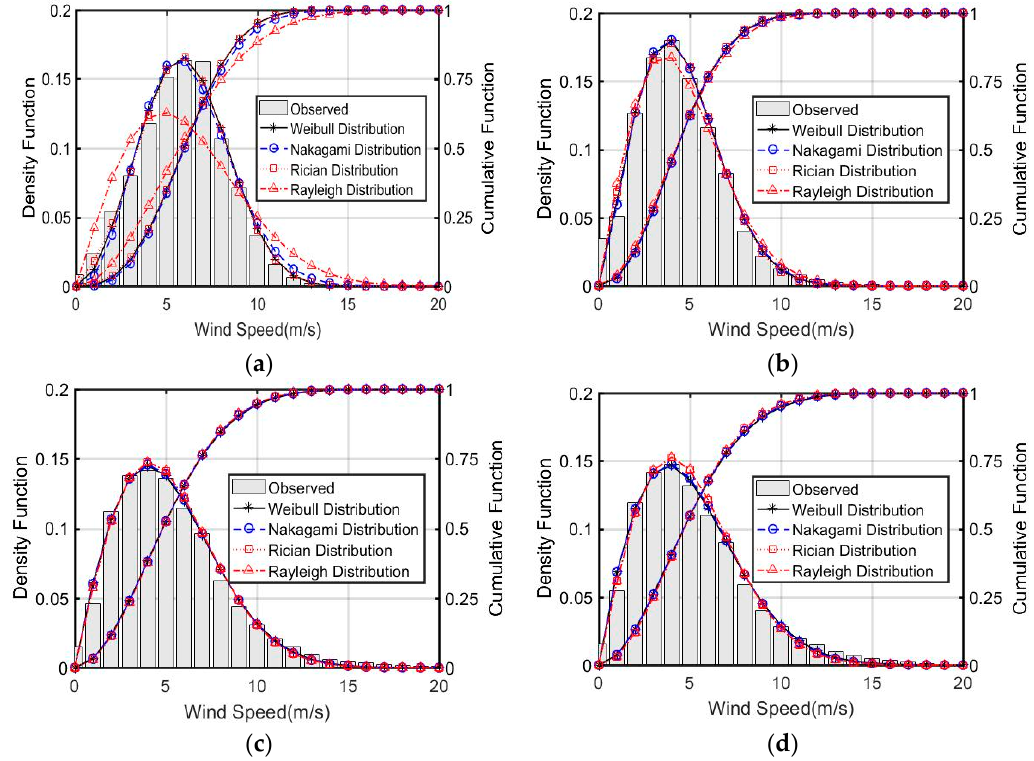
Figure 8. Seasonal wind data and wind speed distributions with different PDFs and CDFs: ( a ) spring; ( b ) summer; ( c ) autumn; ( d ) winter. Table 6. Parameters of corresponding distributions based on annual and seasonal wind data.